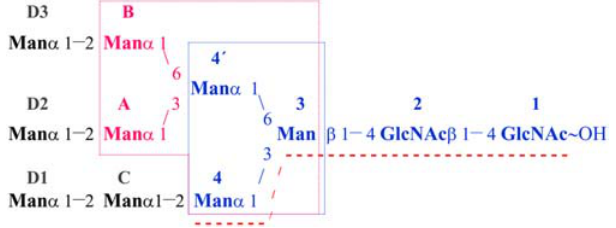
Figure 1. Oligomannose-3 as part of the high-mannose glycans. Oligomannose-9 (K d , 420 nM) is the full structure here displayed. Oligomannose-3 (blue, K d , 20 nM) is the substructure that was crystallized in complex with the FimH adhesin. It interacts with FimH as an extended tetrasaccharide, underlined with a red hatched line. Oligomannose-5 (K d , 12 nM) includes an extra mannotriose core over oligomannose-3 through addition of ManA and ManB (fuchsia). Mannopentaose (K d , 120 nM) and mannotriose (K d , 200 nM) are boxed in fuchsia and blue frames respectively.